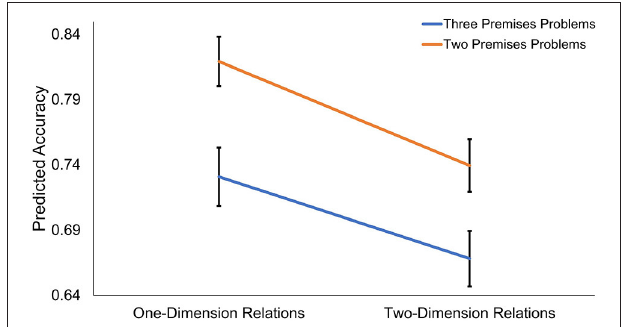
FIGURE 2 | Predicted marginal means from Dimension X Premise interaction model. Results from mixed effects model indicate significant Dimension X Premise interaction. Three-premise problems with two-dimension relations associated with lowest accuracy on relational reasoning task.